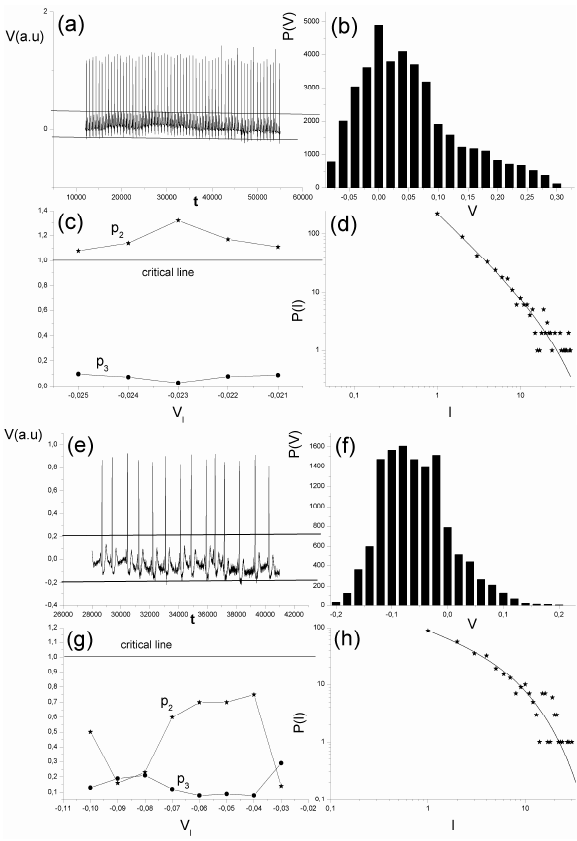
Fig. 2. (a) The CW almost 6.4h long associated with the Kozani– Grevena EQ (b) The histogram of the φ values of (a) . (c) The cor- responding “healthy” exponents p 2 , p 3 vs. the end of laminar re- gion φ l . The critical limit ( p 2 = 1 ) is also depicted. (d) A repre- sentative example of a laminar distribution of the CW for φ l = 220. (e) A noncritical excerpt of the recorded EM time series, following shortly after the CW of (a) , almost 5.5h long. (f) The histogram of φ values of (e) . (g) The “pathological” exponents p 2 , p 3 vs. the end p , 10 of laminar region φ l . The critical limit ( p 2 = 1 ) is also depicted. (h) 2 A representative example of a laminar distribution of the noncritical excerpt for φ l = 350. The departure from critical state is